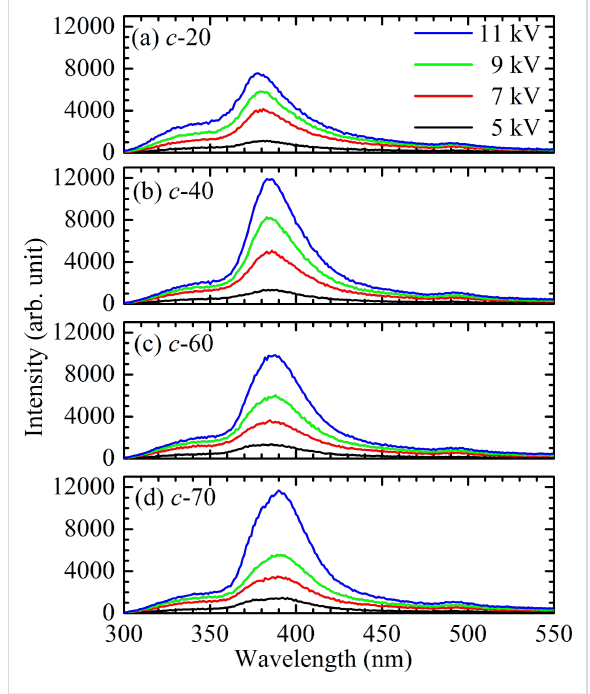
Figure 4: CL spectra of the (a) c -20, (b) c -40, (c) c -60, and (d) c -70 ZnO@B samples for excitations of 5, 7, 9, and 11 kV at RT.